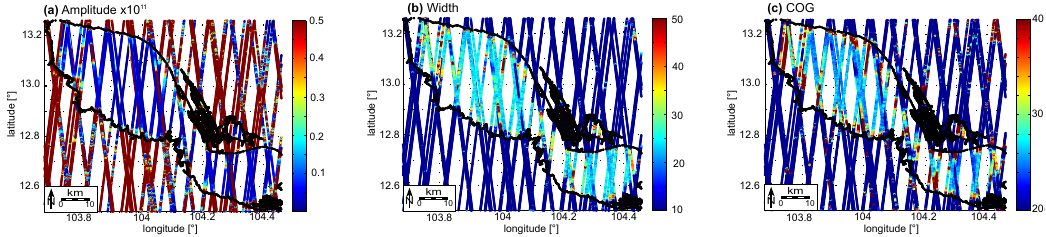
Figure 2. ( a ) Amplitude of the waveform (scaled by 10 11 ); ( b ) width of the waveform; and ( c ) gate position of the waveform center of gravity are shown for the area of Tonle